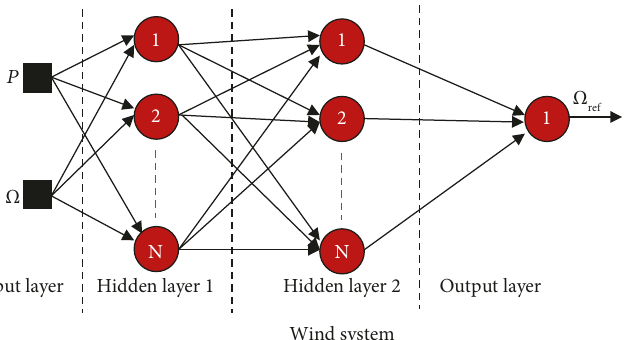
Figure 8: States of PWM recti fi er switches.